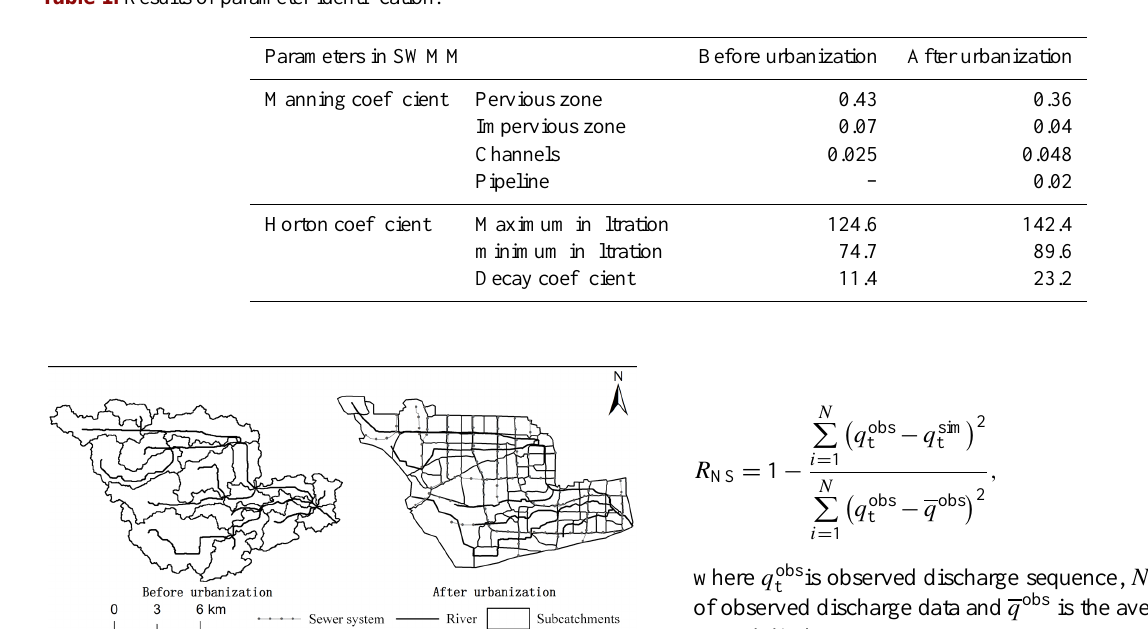
Table 1. Results of parameter identification.